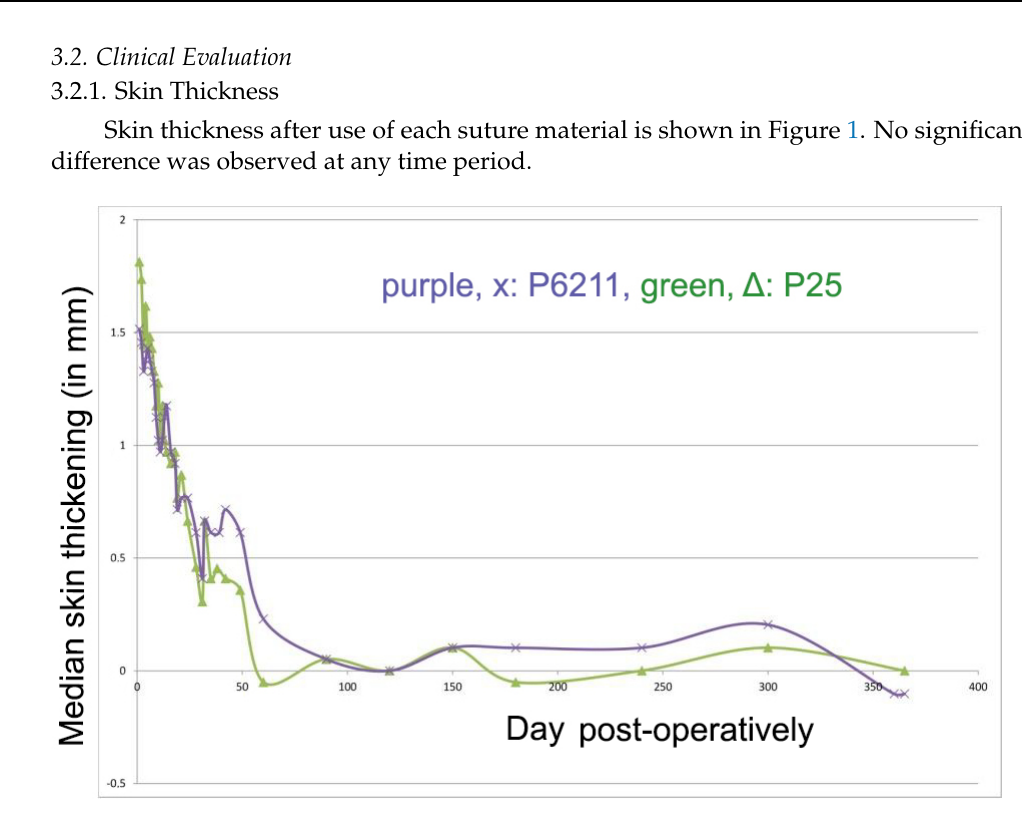
Table 1. Cosmetic scores for each suturing material, given by two different assessors and total cosmetic evaluation throughout the study (median values and interquartile length (in brackets)).